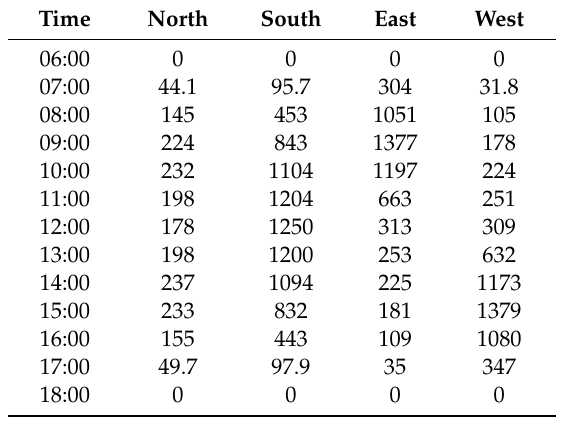
Table 2. Average illuminance (lux) on working plane in case of buildings facing di ff erent directions.